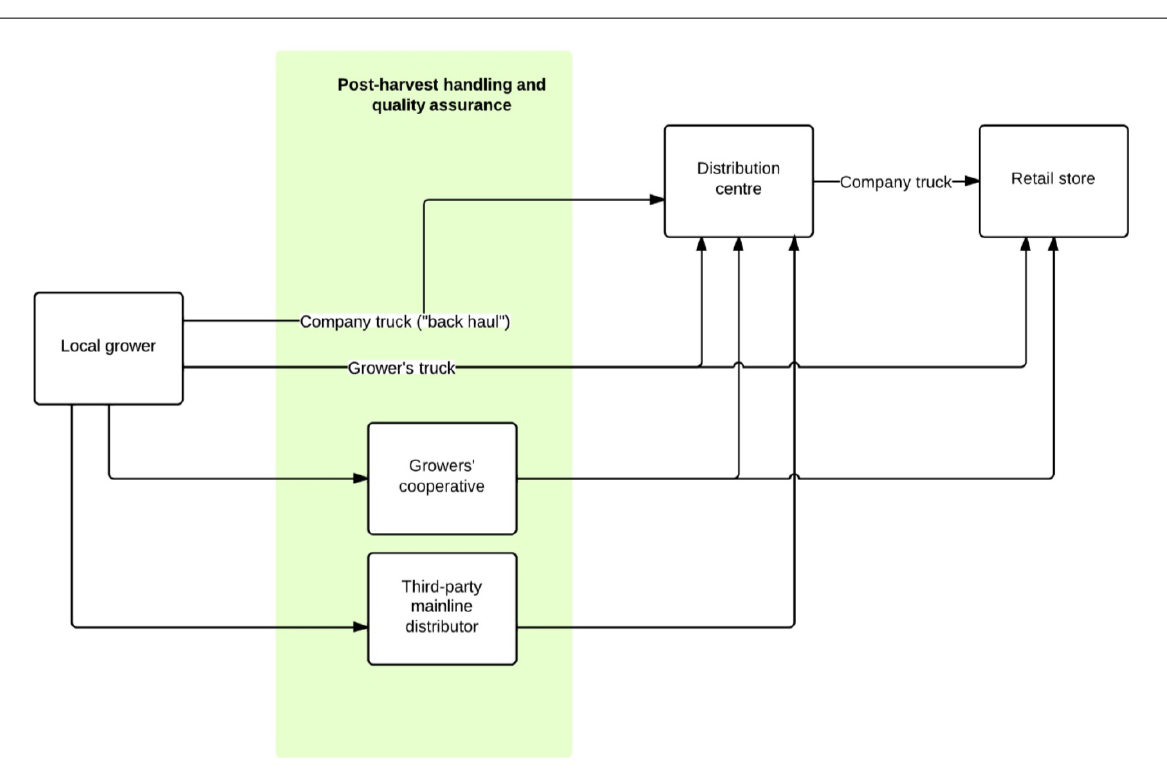
Figure 2. Preferable Local Supply